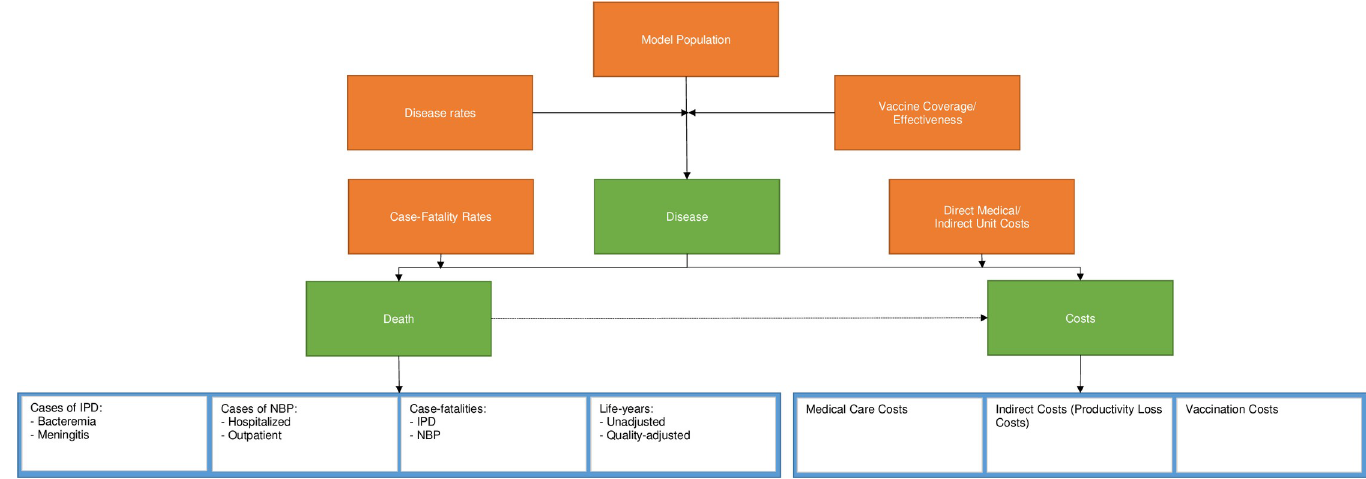
Fig 1. Model schematic. IPD, invasive pneumococcal disease; NBP, non-bacteremic pneumonia.